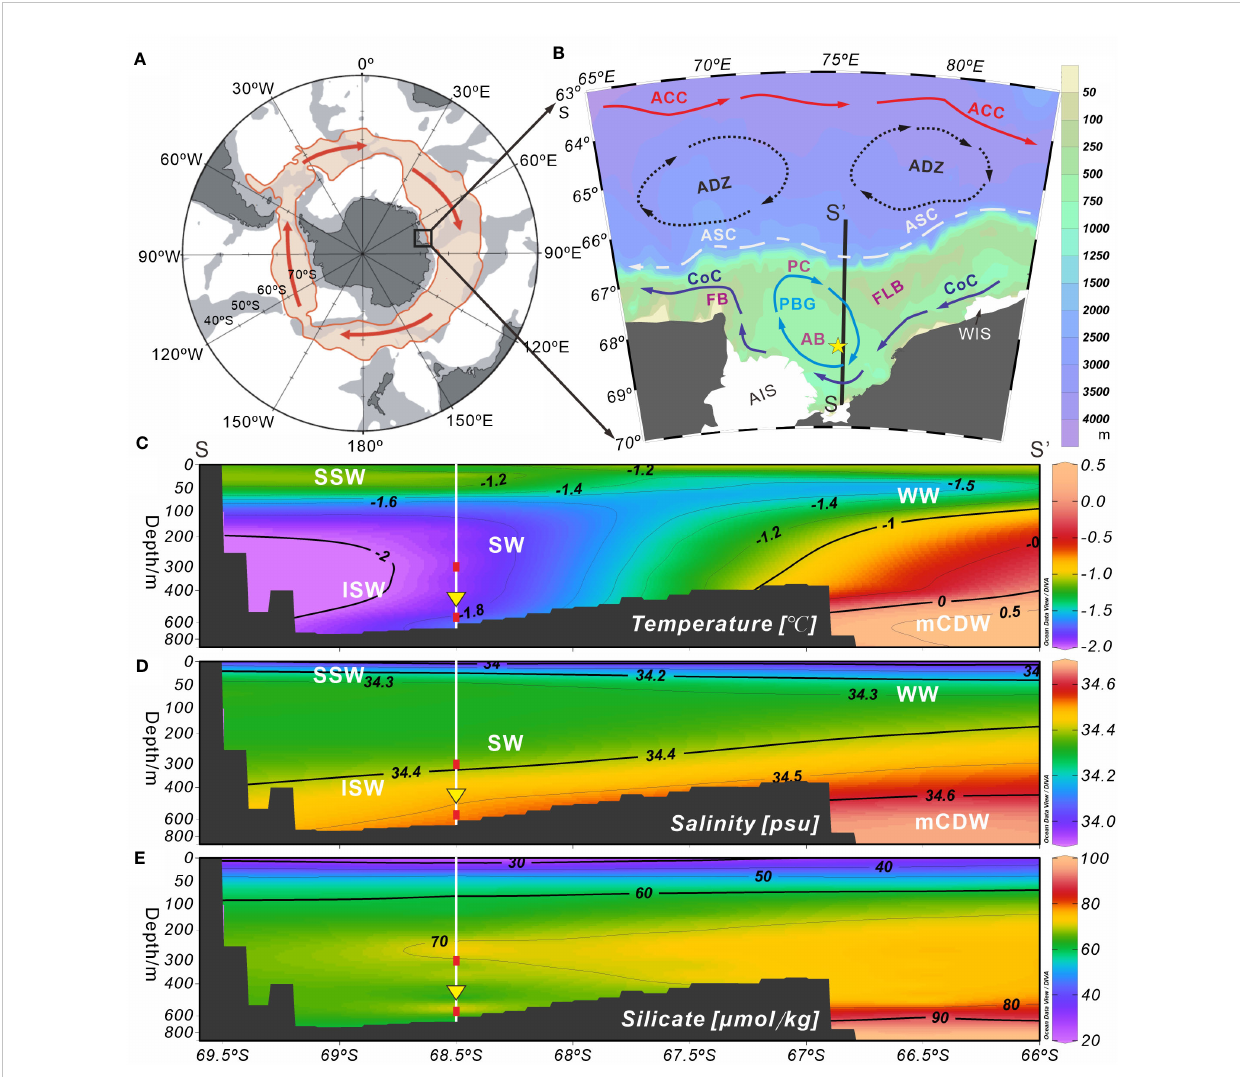
FIGURE 1 Schematic plots of the survey station and environmental setting of Prydz Bay and adjacent areas, Eastern Antarctica. (A) Schematic diagram of the Antarctic region. The light red shaded area of the closed loop represents the fl ow width of the ACC. (B) Station M8 (yellow fi ve-pointed star) and modern surface circulation (arrows) in Prydz Bay. The black solid line (SS ’ ) represents the hydrological location of section 75.5°E in (C – E) . Major current systems (modi fi ed from Wu et al., 2019; Zhu et al., 2019): ACC, Antarctic Circumpolar Current; ADZ, Antarctic Divergence Zone; ASC, Antarctic Slope Current; CoC, Antarctic Coastal Current; PBG, Prydz Bay Gyre. Major geomorphic units: PC, Prydz Channel; FLB, Four Ladies Bank; FB, Fram Bank; AB, Amery Basin; AIS, Amery Ice Shelf; WIS, West Ice Shelf. (C – E) show the water masses and their temperature, salinity and silicate pro fi les (section 75.5°E) near Station M8. The data set representing the climatological annual mean between 1955 and 2010, were obtained from the World Ocean Atlas 2018 (https://odv.awi.de/data/ocean/world-ocean-atlas-2018). Major water masses: SSW, Summer Surface Water; WW, Winter Water; SW, Shelf Water; ISW, Ice Shelf Water; mCDW, modi fi ed Circumpolar Deep Water. White vertical solid lines indicate the location of Station M8. Red squares mark the depths at which the temperature sensors were installed, and yellow inverted triangles indicate the position of the sediment